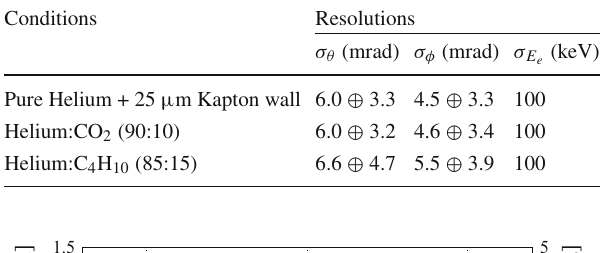
Table 3 Relative θ e γ and φ e γ angles and energy E e uncertainties intro- duced by tracking (first figure) and material effects between the target and the tracking detector (second figure), under different scenarios. In the second and third scenario, the gas in the tracking volume extends to the region around the target to avoid a separation wall. The first track- ing layer is placed at R e = 20 cm. The photon detector is placed at R γ = 30 cm. The tracking resolutions of MEG-II are assumed. Notice that, due to the correlations among variables, tracking and material con- tributions do not decouple completely – increasing the material effects